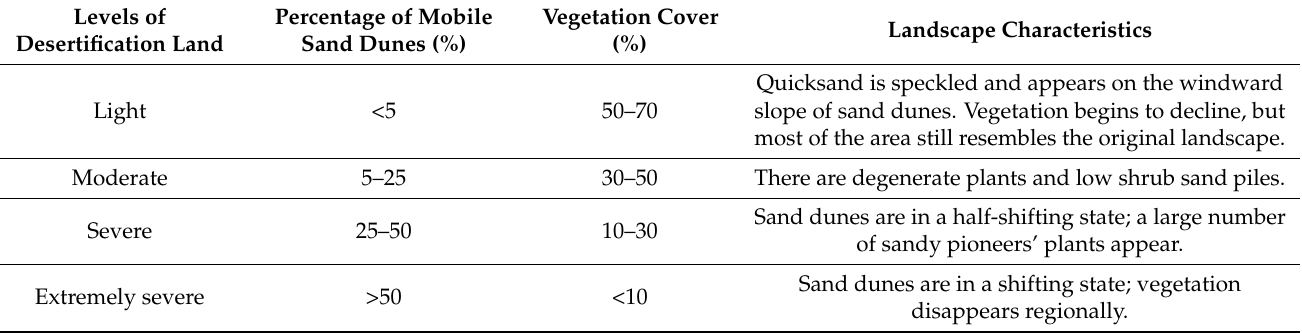
Table A1. Classification system of desertification land.